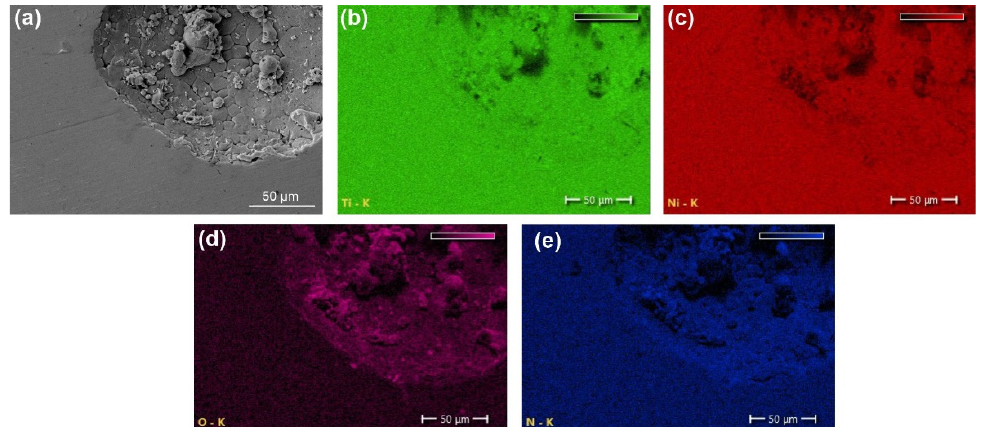
Figure 8. Energy-dispersive analysis of the interpore bridge of porous NiTi-(Ar) alloy: ( a ) SEM image, and ( b ) Ti, ( c ) Ni, ( d ) O, and ( e ) N maps.